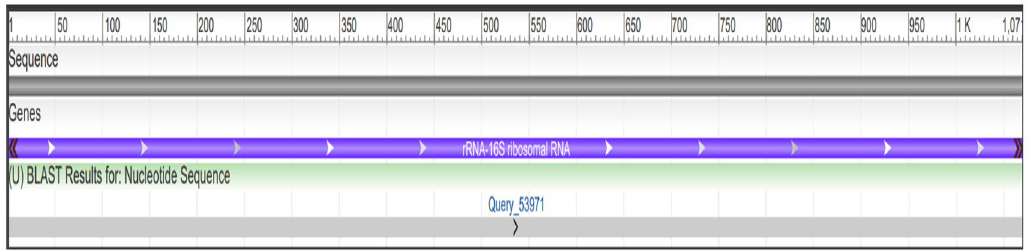
Fig. 2. Exiguobacterium profundum gene for 16S rRNA, partial sequence, strain: RP-L-5 1,238 bp linear DNA GenBank: LC019791.1, species, firmicutes